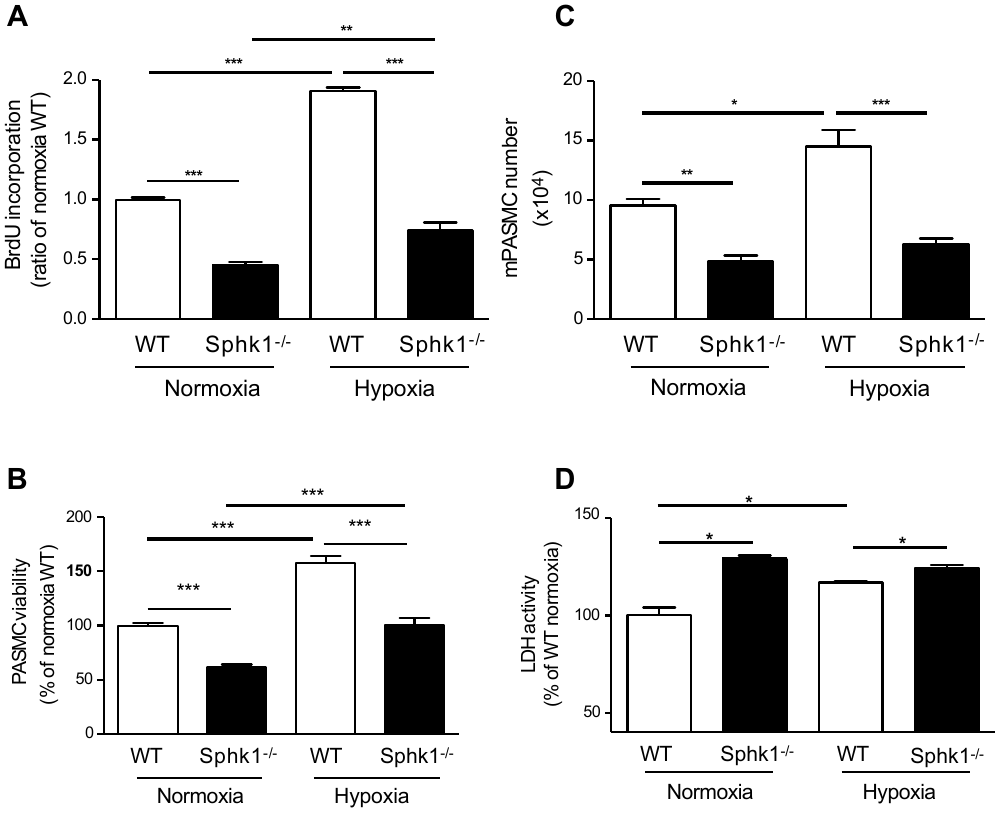
Figure 4. PASMCs isolated from Sphk1 knockout ( Sphk1 -/- ) mice are less proliferative than in WT mice under normoxia or hypoxia exposure. Cell proliferation was measured with a 5-bromo-2 ′ -deoxyuridine (BrdU) incorporation assay ( A ), a viability assay ( B ), cell counting ( C ), and an LDH assay ( D ). Data are expressed as mean ± SEM (n = 4). * p < 0.05; ** p < 0.01; *** p < 0.001; bars indicate the comparison between groups.